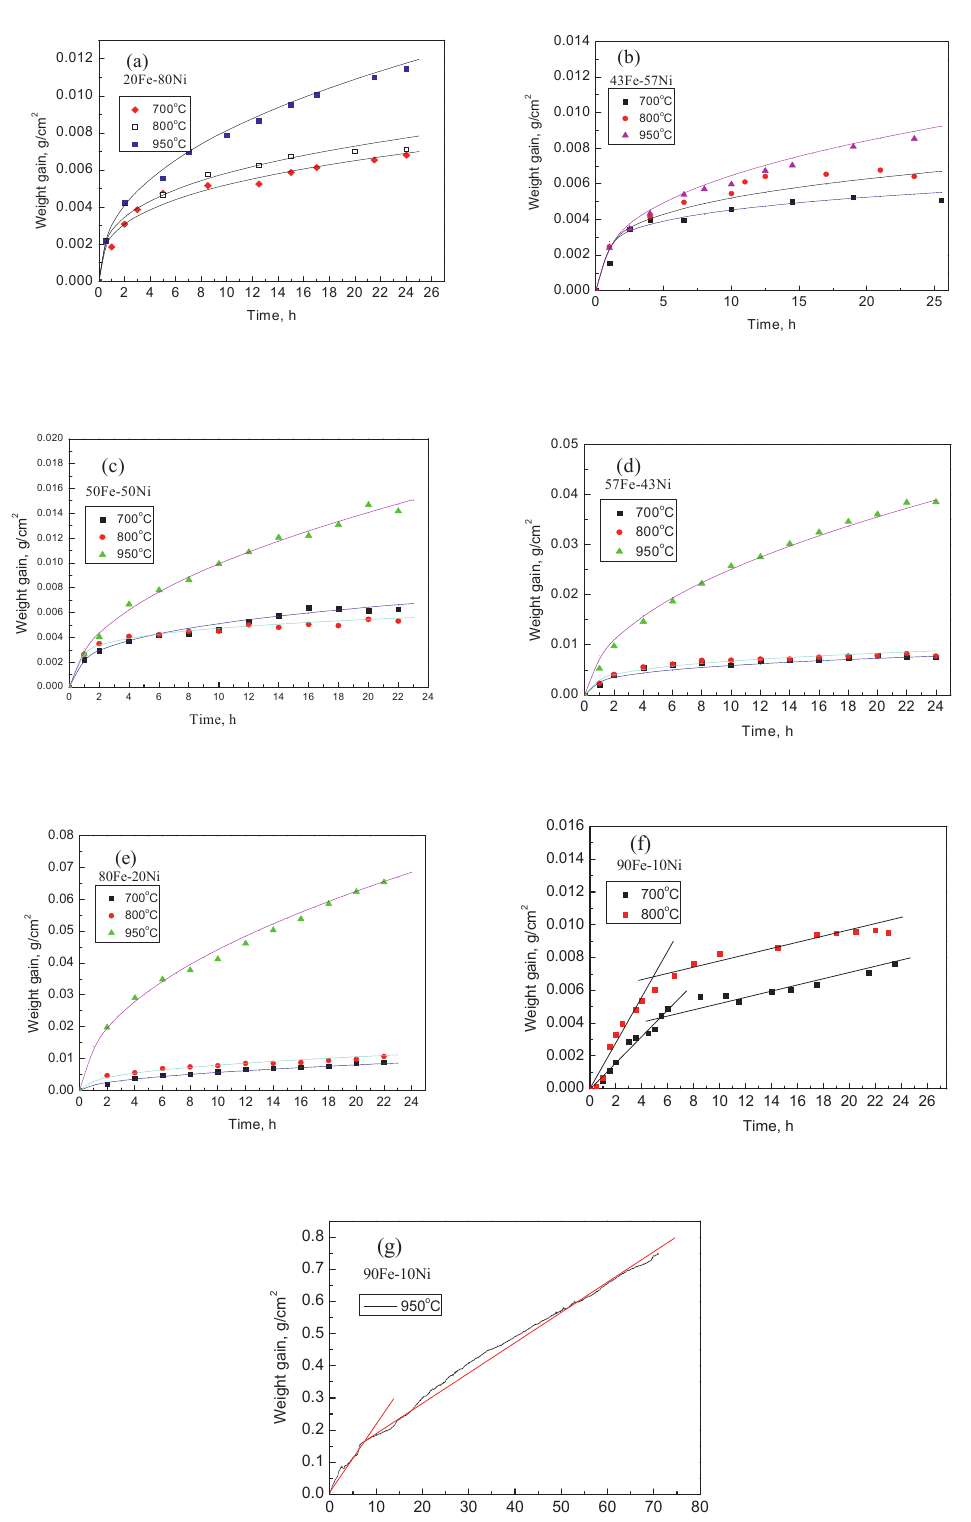
Figure 1. Fe-Ni alloys oxidation weight gain as a function of